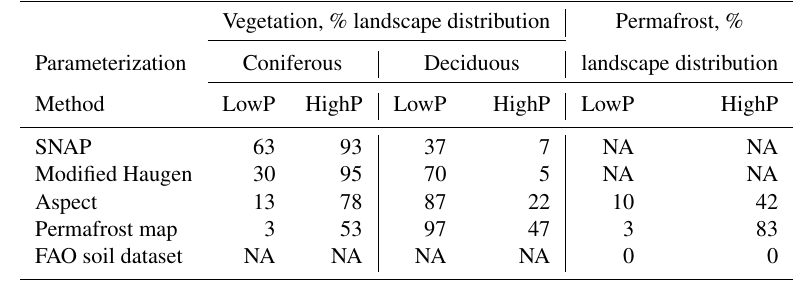
Table 3. Estimated percent of the sub-basins (LowP and HighP) covered by coniferous and deciduous vegetation, and percent of the sub- basins underlain by permafrost. Values were obtained by applying different parameterization methods: SNAP vegetation cover (SNAP), a modified Haugen et al. (1982) vegetation cover map (modified Haugen), aspect-derived vegetation cover (aspect), the CPCRW permafrost map (permafrost), and large-scale FAO digital soil map of the world (FAO soil dataset). NA indicates that a given method was not utilized to obtain values for either the vegetation or permafrost distribution.